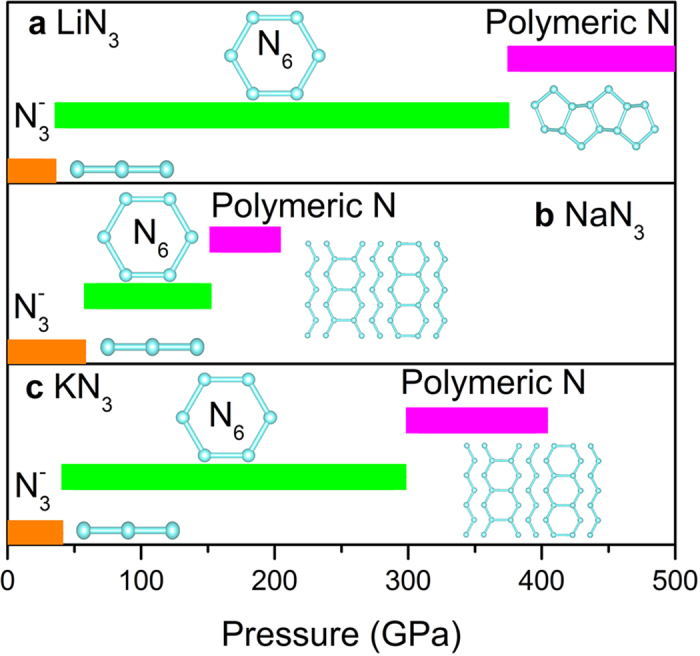
Structural evolution of N3- anion in alkali metal azides under compression.(a) LiN3, (b) NaN3, and (c) KN3. Transition pressure and structures are taken from reference LiN34, NaN35, and KN37, respectively.